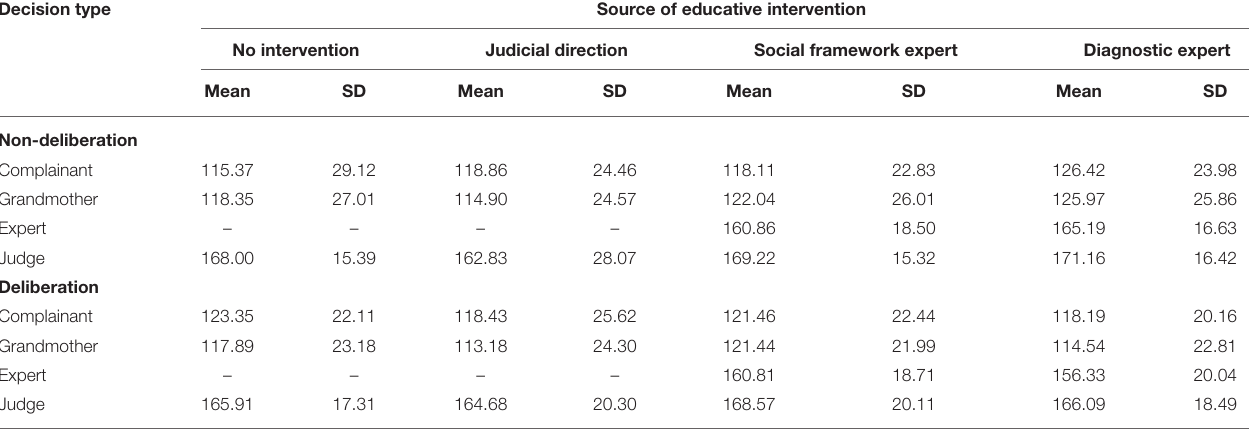
TABLE 4 | Perceived credibility of witnesses and the judge by decision type and experimental